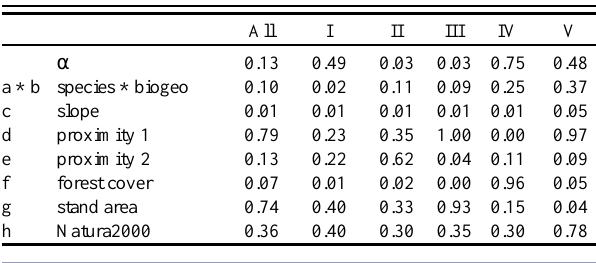
Table 6 . Sensitivity of the map to data sources. Fraction of pixels that changed dominant forest management approach (FMA) after removal of the different data sources (a–h)